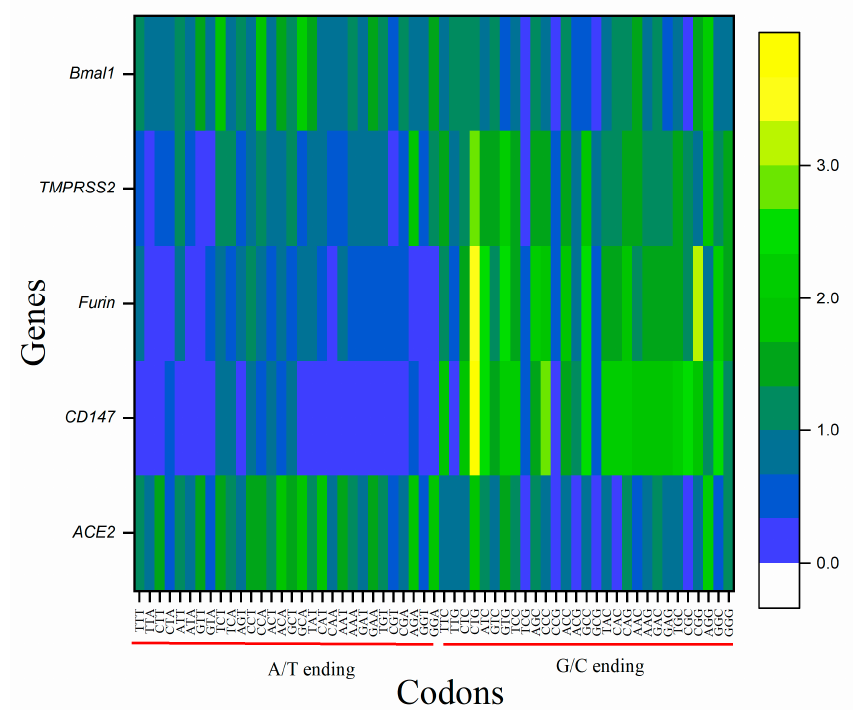
Figure 3. Heat map analysis for RSCU values of A/T and G/C ending codons of ACE2 , CD147 , FURIN, TMPRSS2 , and BMAL1 . Analysis revealed the dominance of G/C ending codons in CD147 , FURIN , and TMPRSS2 genes while the dominance of A/T ending codons in ACE2 and BMAL1 . 3.4. Codons CGT, TCG and CTA Are Rarely Used in All the Genes Table 1. Average RSCU values of ACE2 , CD147 , FURIN , TMPRSS2, and BMAL1 genes. Codon usage bias is ruled by several mechanisms, resulting in various